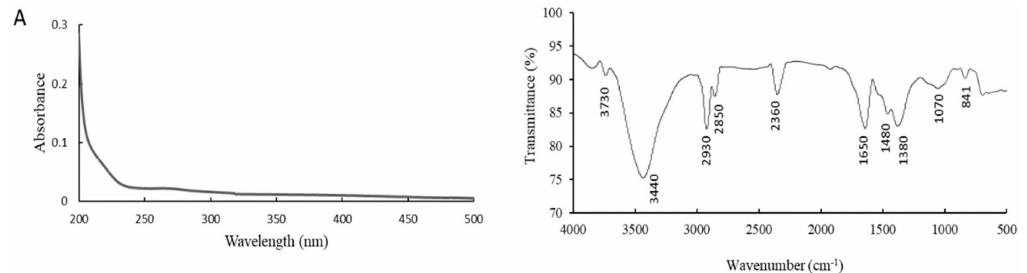
Figure 7. UV ( A ) and FT-IR ( B ) spectrum of